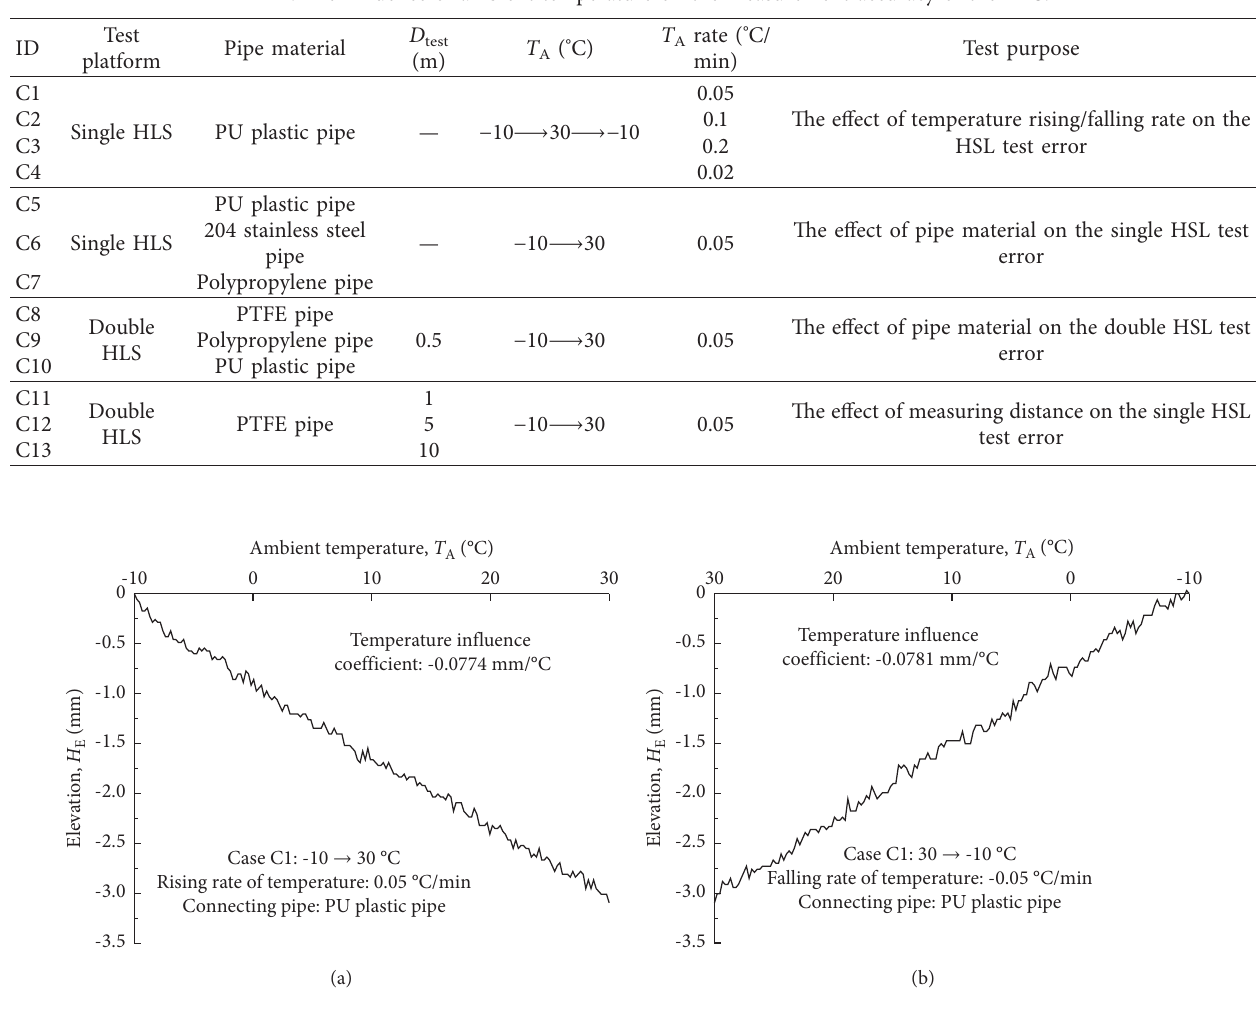
Figure 2: The influence of temperature rise/fall rate on the measurement accuracy of the HLS. (a) Ambient temperature rising. (b) Ambient temperature falling.